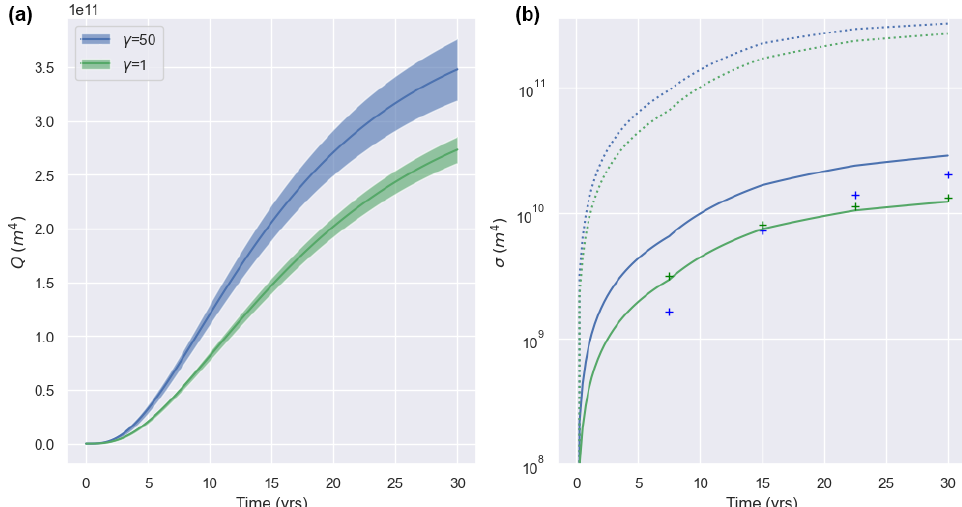
Figure 6. (a) Paths of Q IS in the γ 50 experiment (blue) and γ 1 experiment (green). Shading shows the 1 σ uncertainty interval for each T trajectory calculated by projecting the Hessian-based (posterior) uncertainty along the linearized trajectory. (b) Uncertainties in the time- dependent experiments over time. Dashed lines: prior uncertainties projected along the linearized Q IS posterior uncertainties projected along the linearized trajectory. Markers: standard deviation of Q IS both panels, green corresponds to γ 50 and blue to γ 1